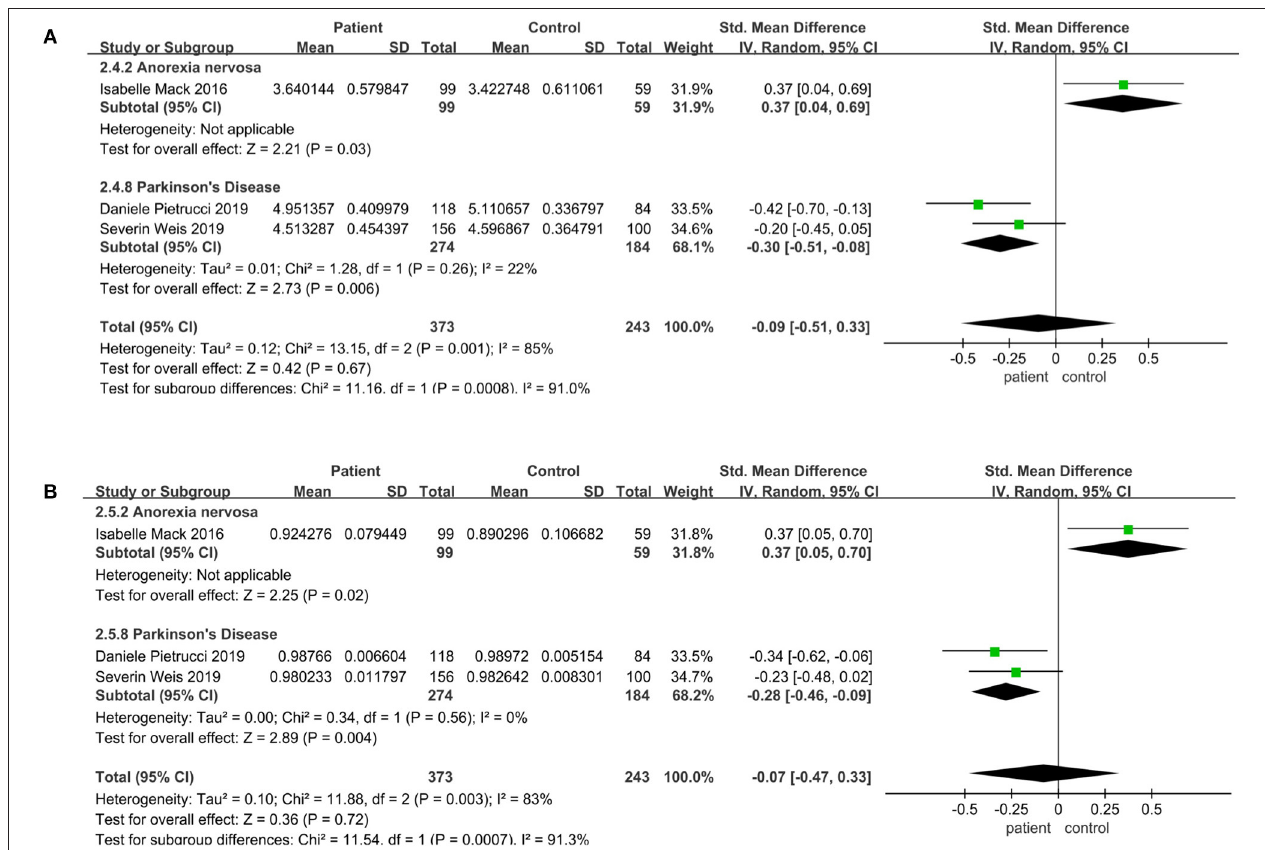
FIGURE 3 | Community diversity meta-analyses for different diseases. Forest plot for the Shannon (A) and Simpson (B) . SMD, standardized mean difference; SD, standard deviation.